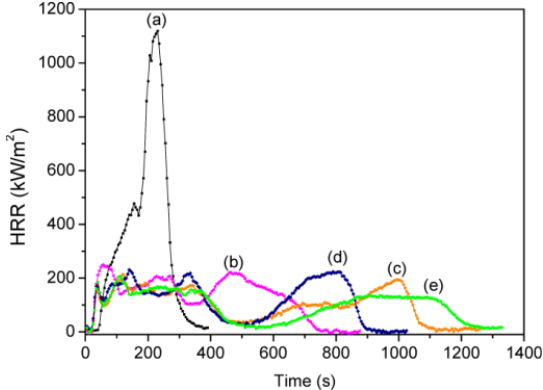
Figure 5. HRR (heat release rate) curves of the pure EVA and composites. ( a ) EVA; ( b ) ELDH-0; ( c ) ELDH-Ni; ( d ) ELDH-Co; and ( e ) ELDH-Cu.